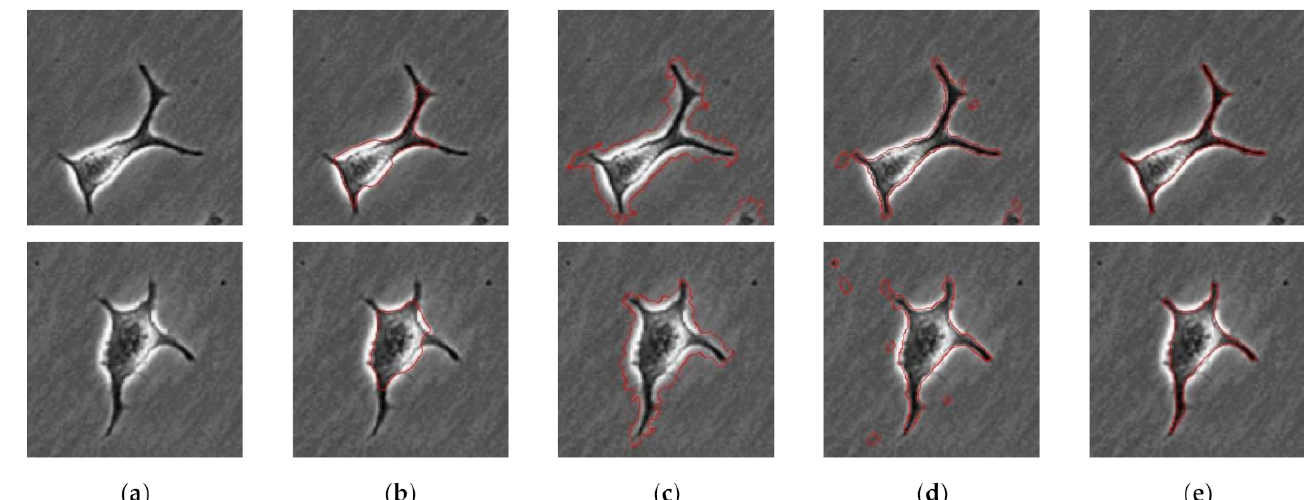
Figure 6. Comparison of segmentation results for different methods. Each column represents the same method results. ( a ) Original phase contrast microscopic image. ( b ) Segmentation result with active contour method. ( c ) EGT method. ( d ) PHANTAST method. ( e ) Proposed